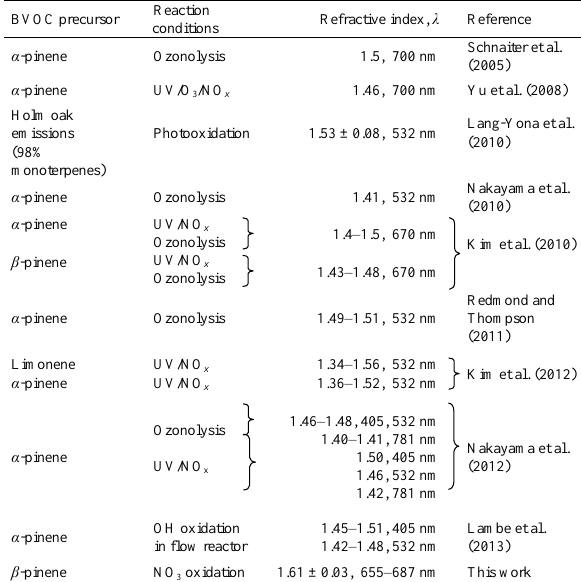
Table 5. Refractive indices of SOA formed from